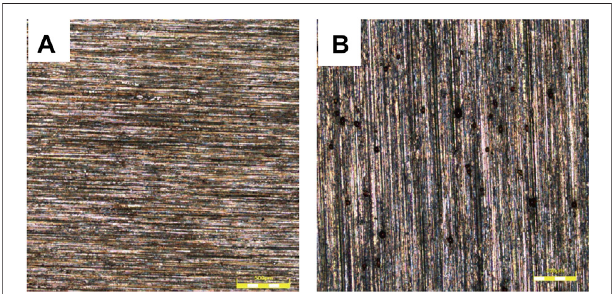
FIGURE 2 | Micro-morphology of 825 sample after the immersion tests at different temperatures without remove corrosion products: (A) no pit observed at 150 ° C. (B) black pits founded at 230 ° C.